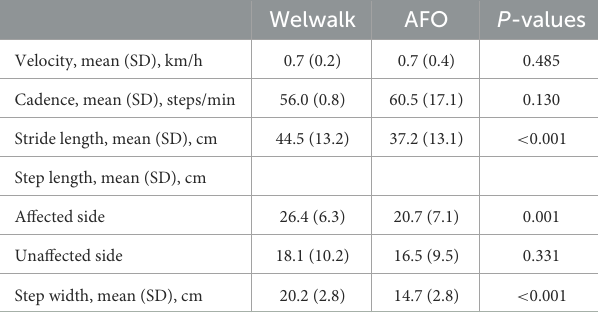
TABLE 3 Spatiotemporal parameters of